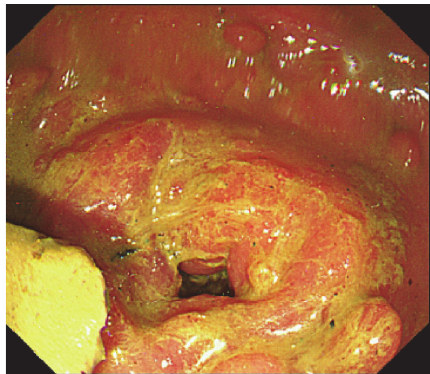
Figure 4: The patency capsule was found to be surrounded by colonic feces.